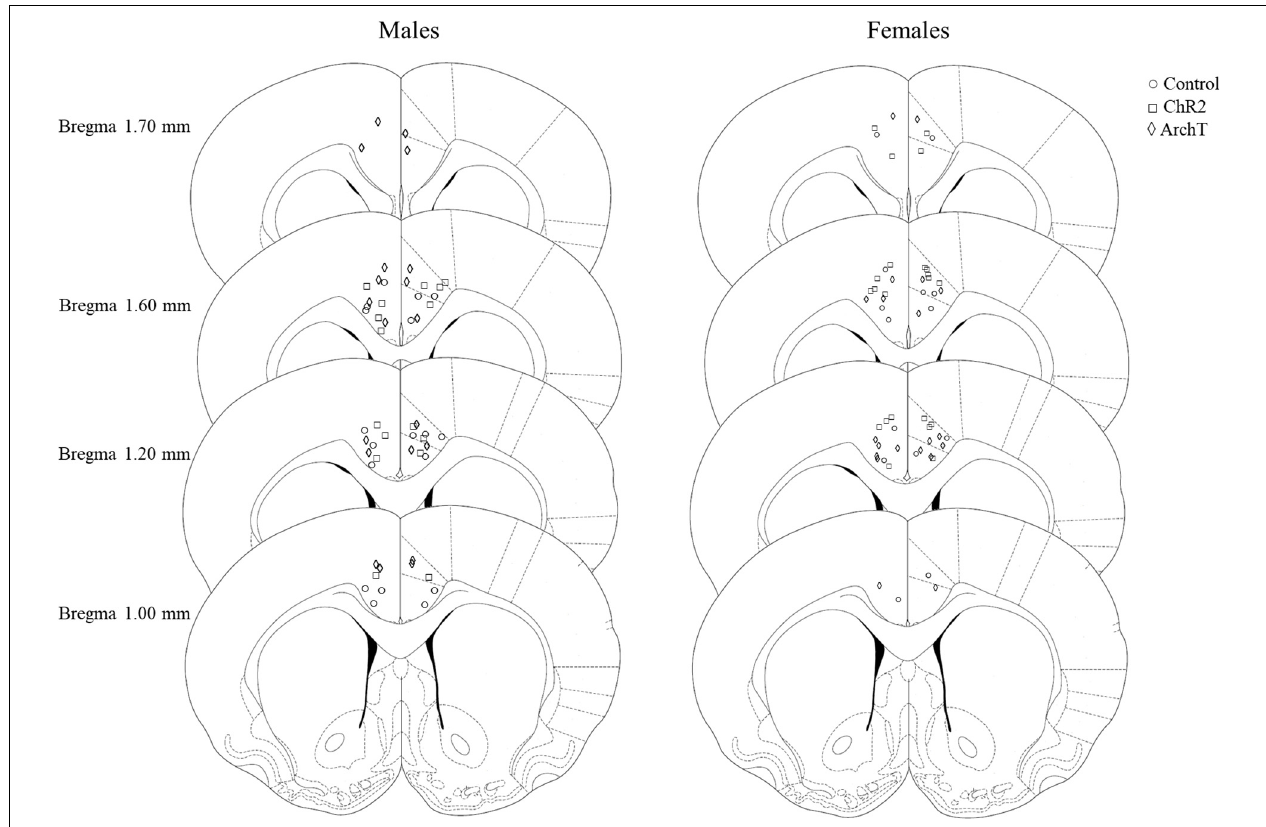
FIGURE 2 | Schematic depicting sites of optical fiber implantation in the left and right ACC of male and female rats, adapted from Paxinos and Watson (2007).